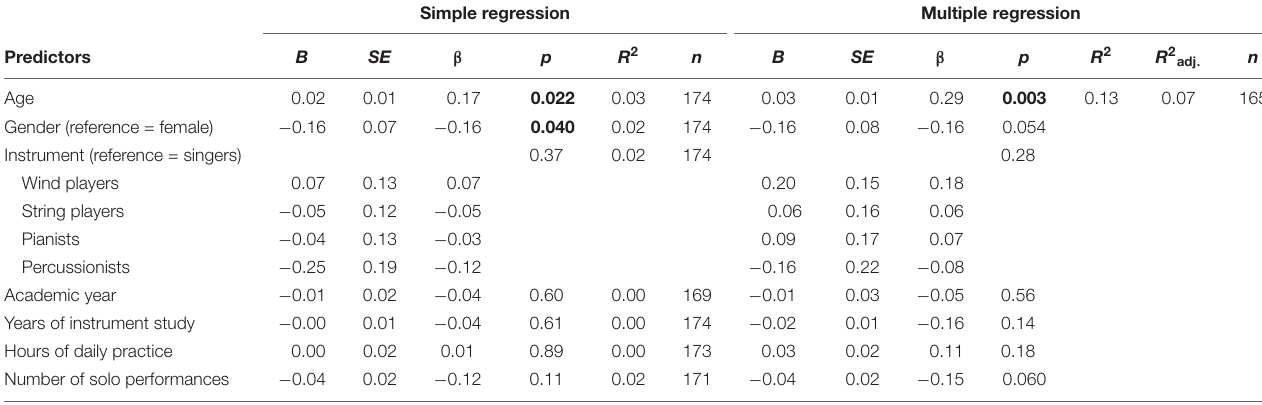
TABLE 5 | Results of the linear regression analyses for breathing-related complaints.